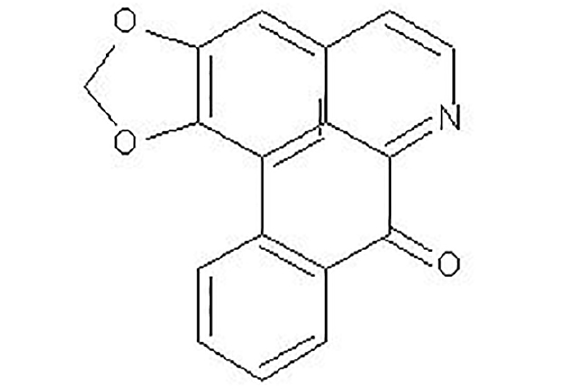
Figure 1. Structure of